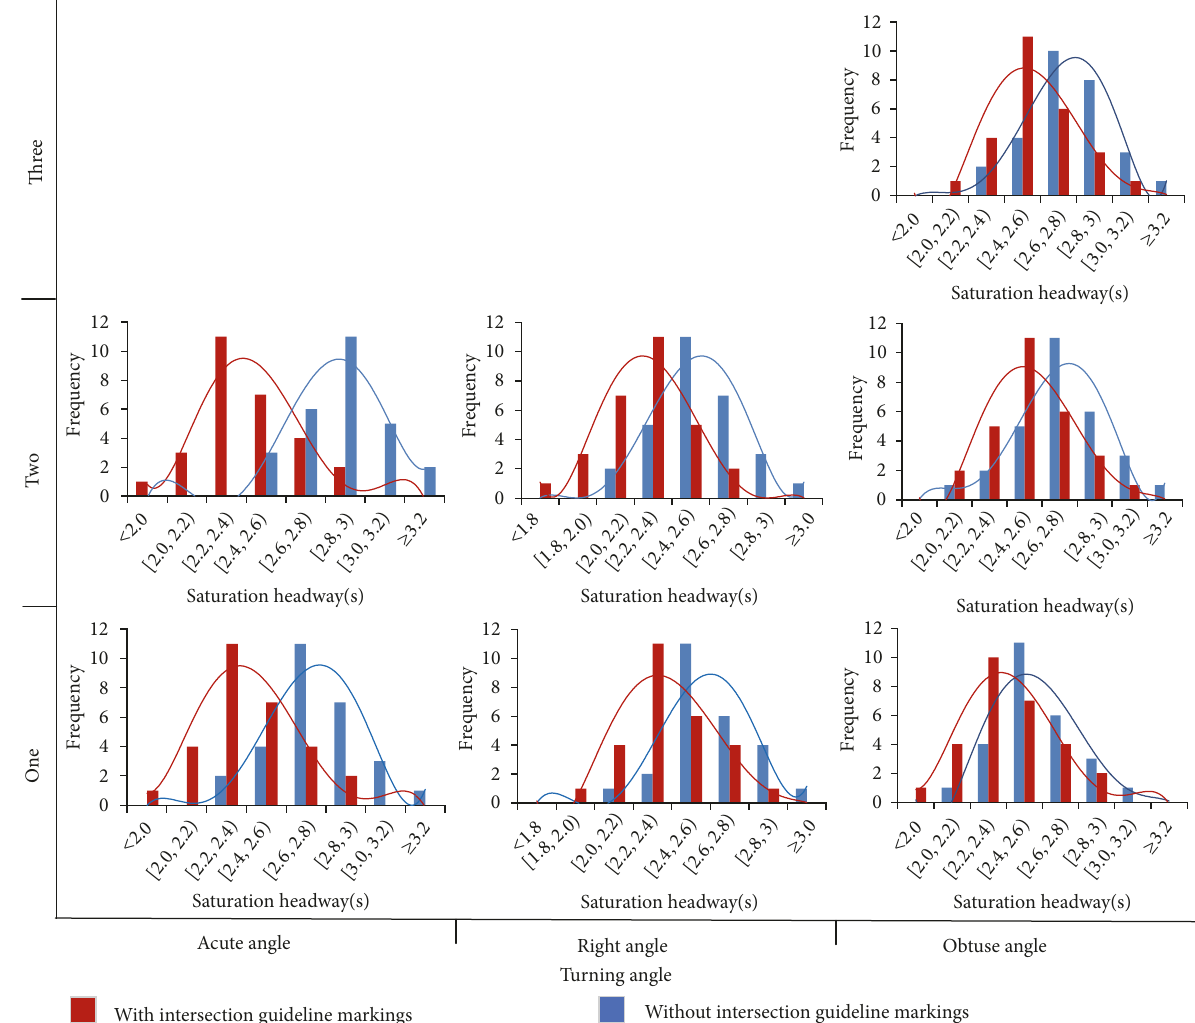
Figure 6: Comparison of left-turn headways with and without guideline markings.